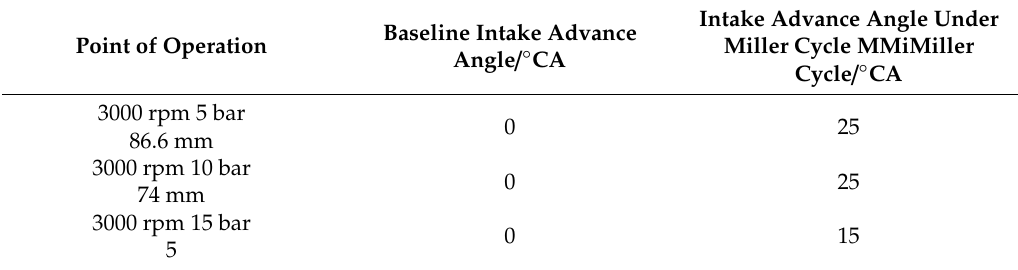
Table 3. Values of intake advance angle at different points of operation when exhaust retardation angle is analyzed under Miller cycle.